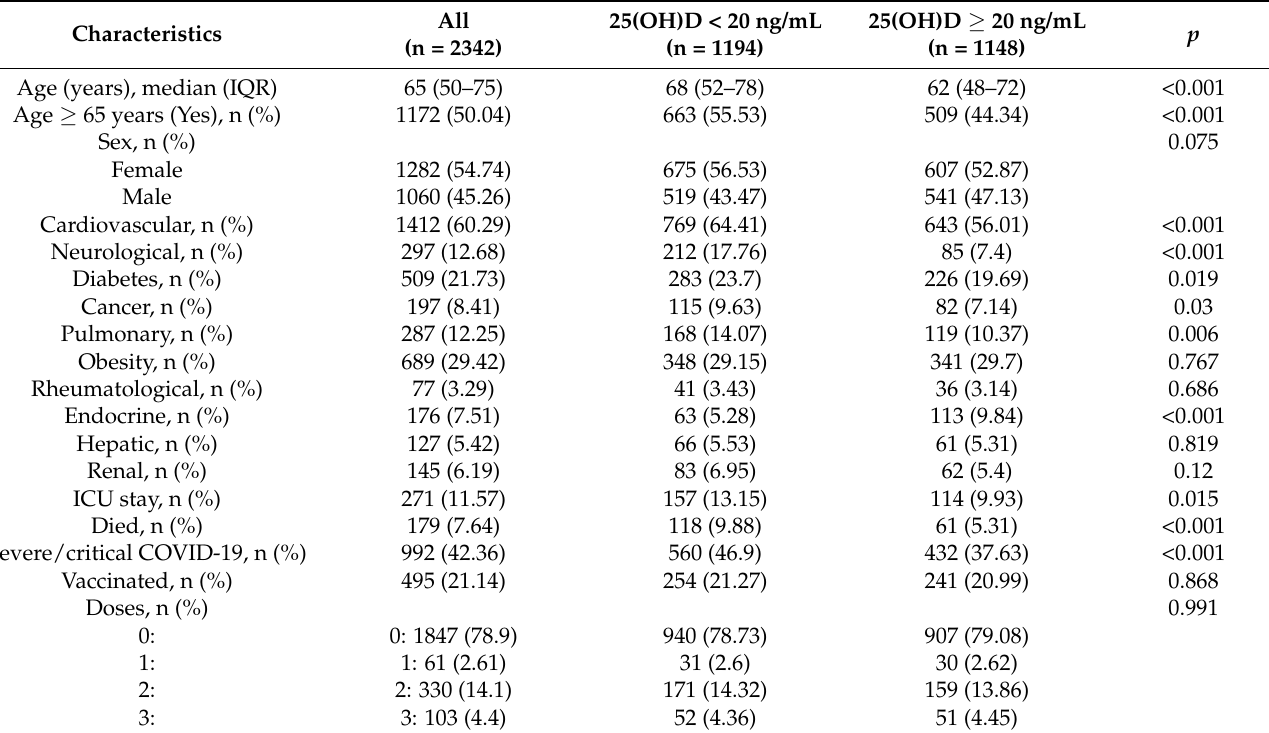
Table 1. Demographics, clinical data, comorbidities, and vaccination status of the study group.